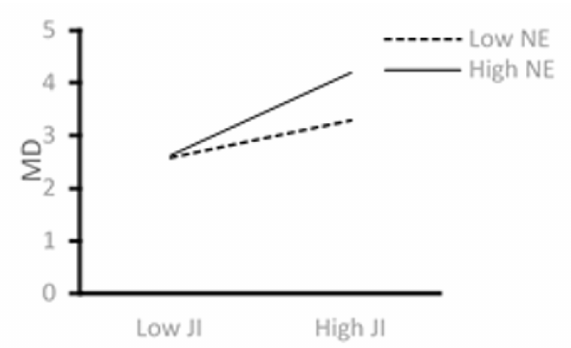
Figure 4. The moderating role of